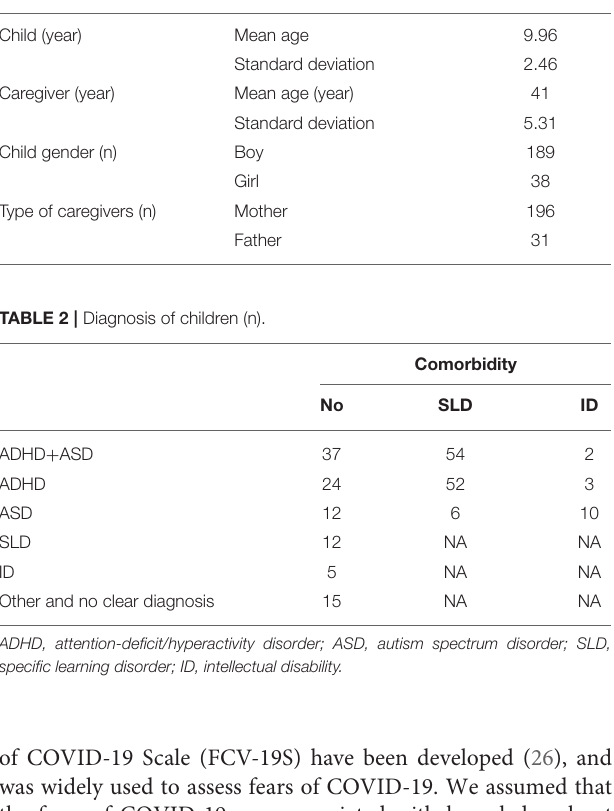
TABLE 1 | Characteristics of participants.